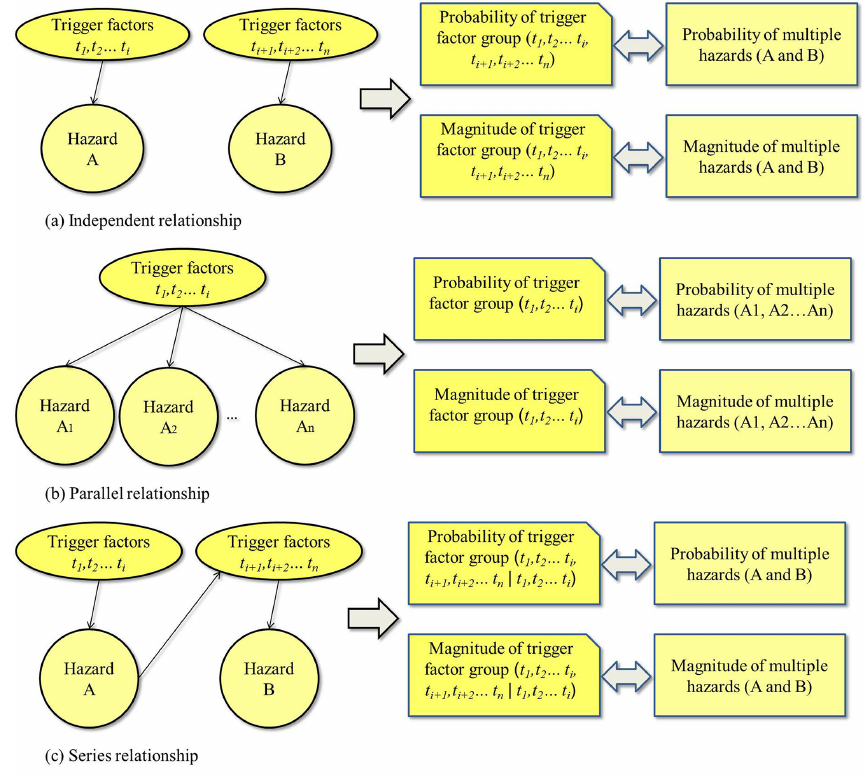
Figure 2. Hazard interaction analysis for hazards with different relationships. (a) Independent relationship. (b) Parallel relationship. (c) Series